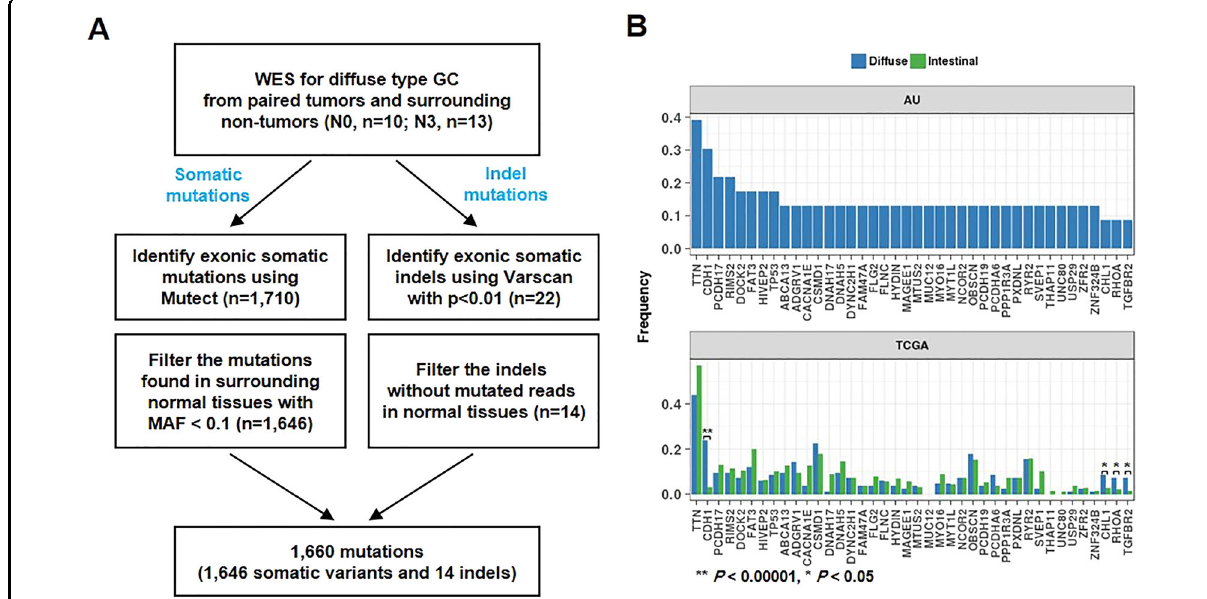
Fig. 1 Identi fi cation of somatic variation in DGCs. a Work fl ow for identifying somatic variants in 23 DGCs. Somatic mutations and indels were identi fi ed using Mutect and Varscan software, respectively. Mutated allele frequencies (MAF) are indicated. b Bar plots show the frequency of the recurrent variations in the DGC data ( n = 23, top) and the DGC ( n = 84) and IGC ( n = 191) data from TCGA (bottom). The signi fi cance of the mutation frequency of DGC compared to that of other types is indicated (** P < 0.00001, * P < 0.05)